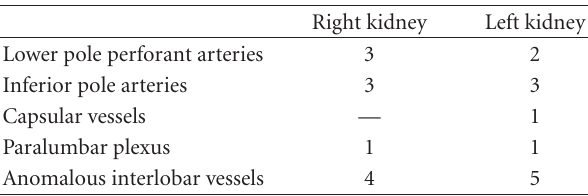
Table 3: Vascular abnormalities at the colour doppler ultrasono- graphic examination before